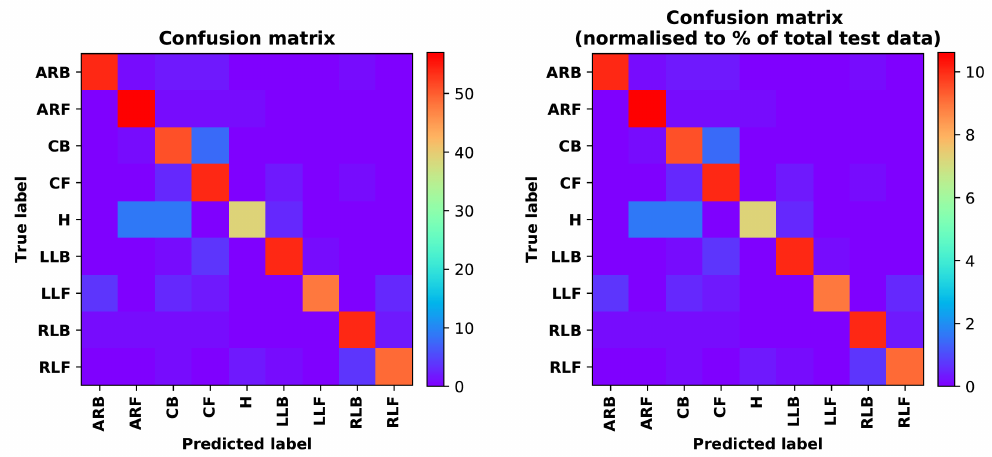
Figure 14. Left graph is the confusion matrix of classification test using the model trained by LSTM network; right is the normalised confusion matrix.